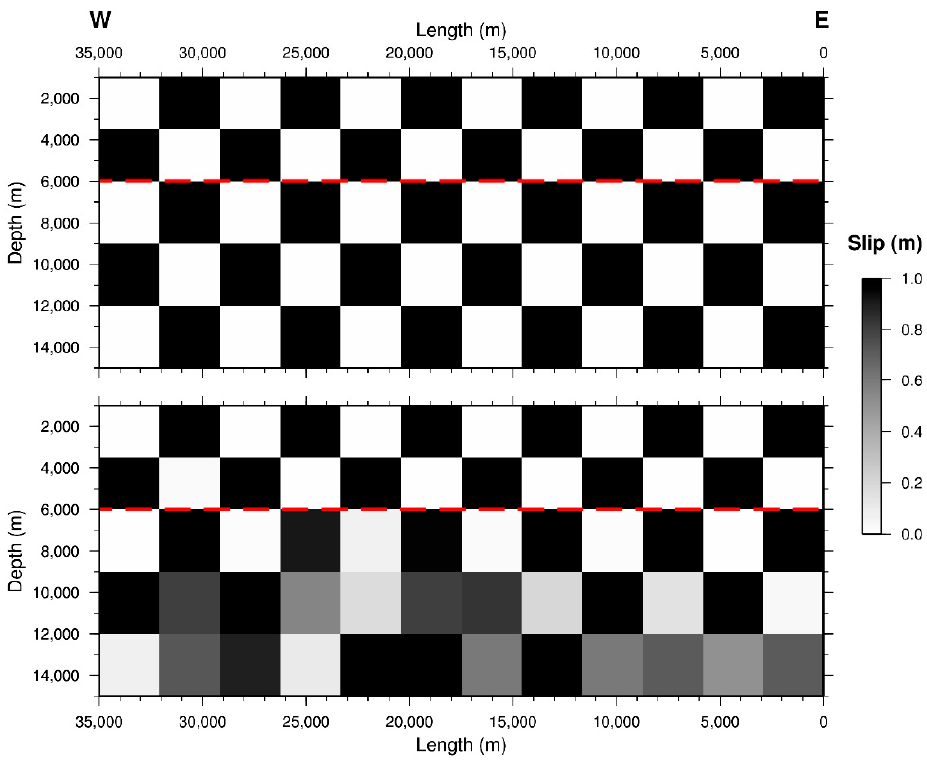
Figure A1. Results of checkerboard test (smoothing factor k = 100) for the optimal plane discretization. Red dashed line defines the limits of segments along the dip direction. The grey scale gives the magnitude of dip-slip variation.